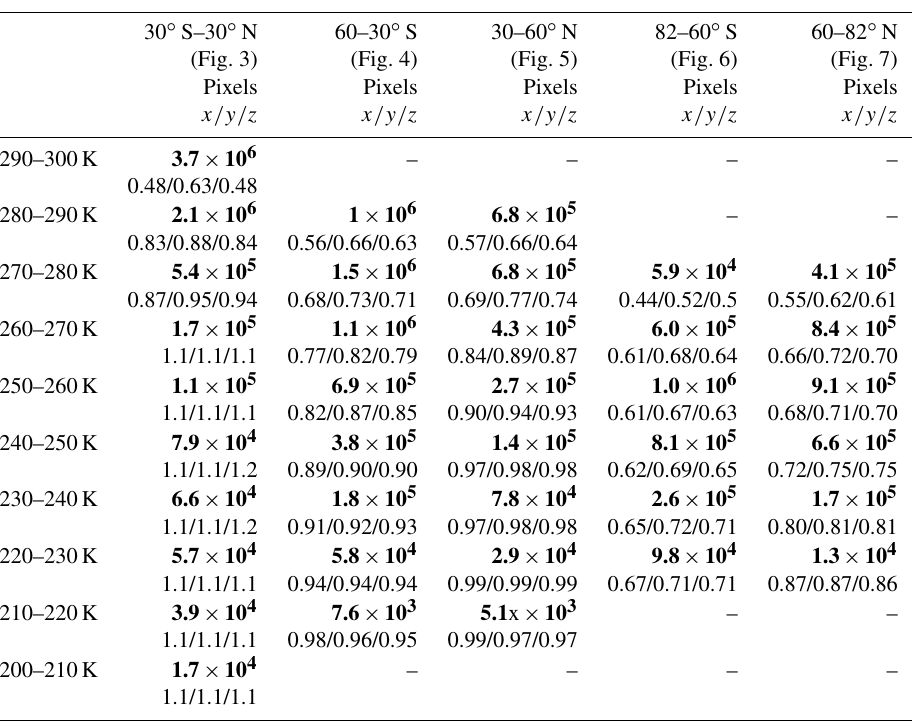
Table 5. Mean number of pixels per day (bold) and mean standard deviations in Kelvin (from left to right: x = IIR1–MODIS29, y = IIR2– MODIS31, and z = IIR3–MODIS32) associated with Figs. 3 to 7.